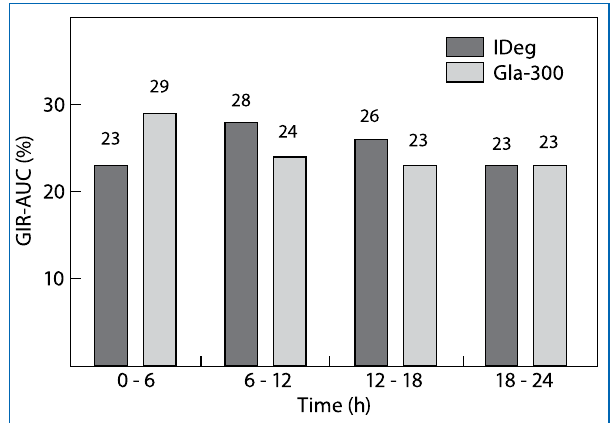
Notes: The glucose clamp studies were performed at a steady-state of IDeg and Gla-300. A dose of 0.4 IU/kg was used for both longer-acting basal analogue insulins. Figure 1: Diurnal fluctuations in the glucodynamics of IDeg 9 and Figure 1: Diurnal fluctuations in the glucodynamics of IDeg 9 and Gla-300. 12 Gla-300. 12 Table 1: Comparison of published glucose clamp results of insulin degludec (IDeg) and insulin glargine U300 (Gla-300) Factor Insulin degludec